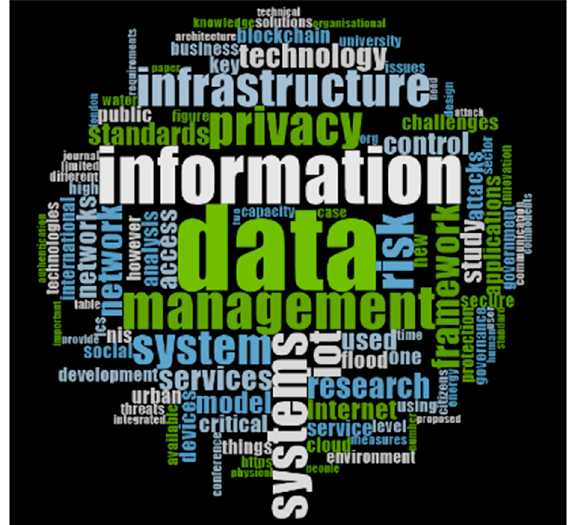
Figure 2. Word cloud result from NVIVO 12.